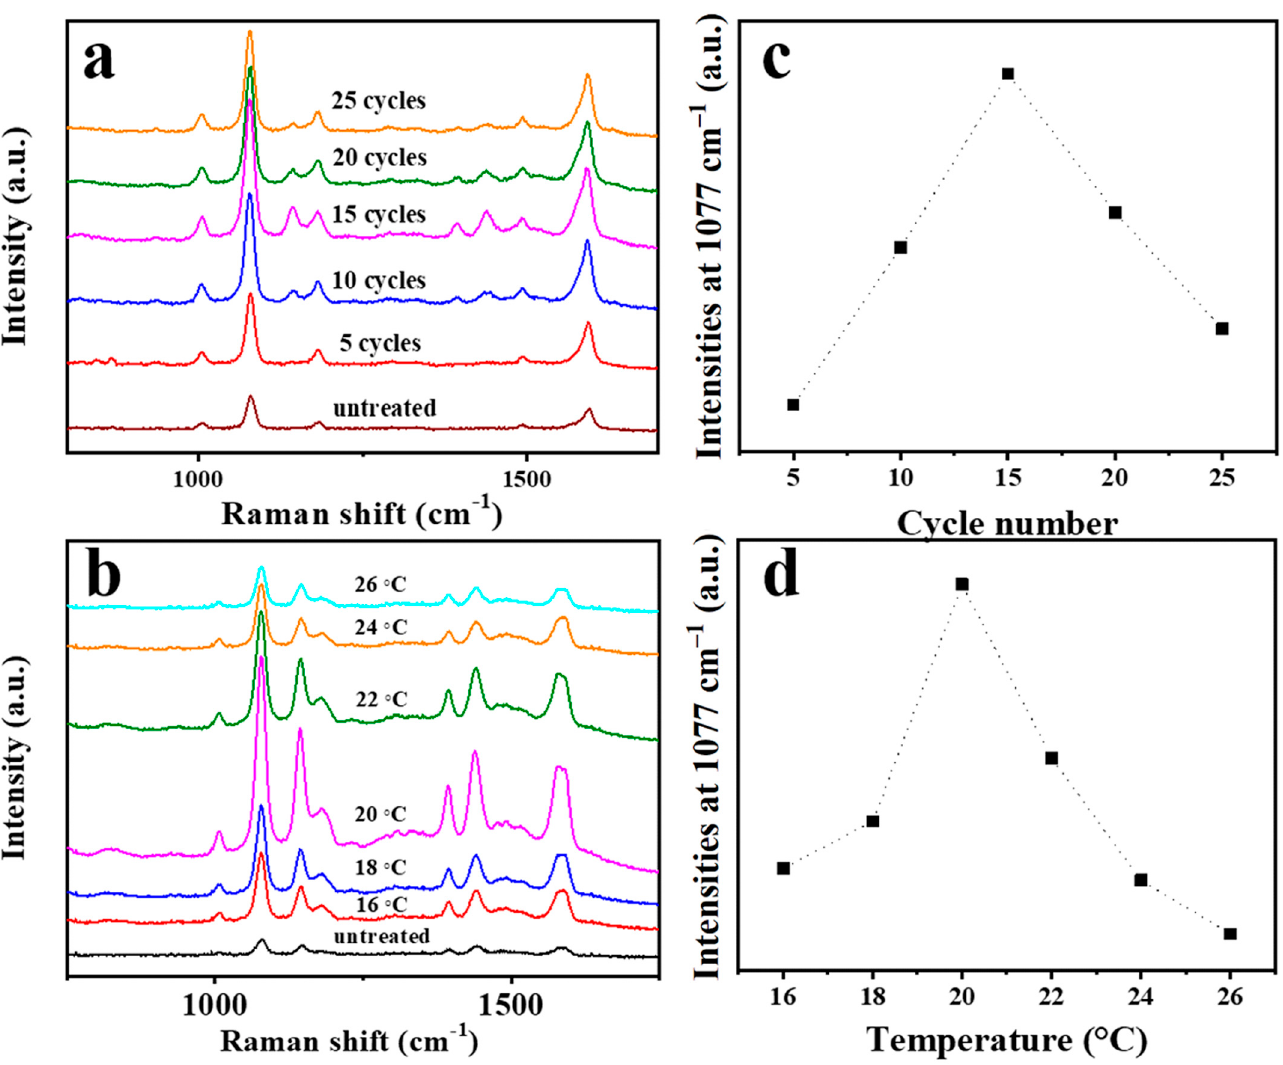
Figure 4. Surface-enhanced Raman spectroscopy (SERS) spectra of p-aminothiophenol (10 − 6 M) used as a probe molecule on silver nanowire membranes according to the CV cycle number ( a ) and treatment temperature ( b ). SERS intensities at 1077 cm − 1 as a function of the cycle number ( c ) and treatment temperature ( d ).